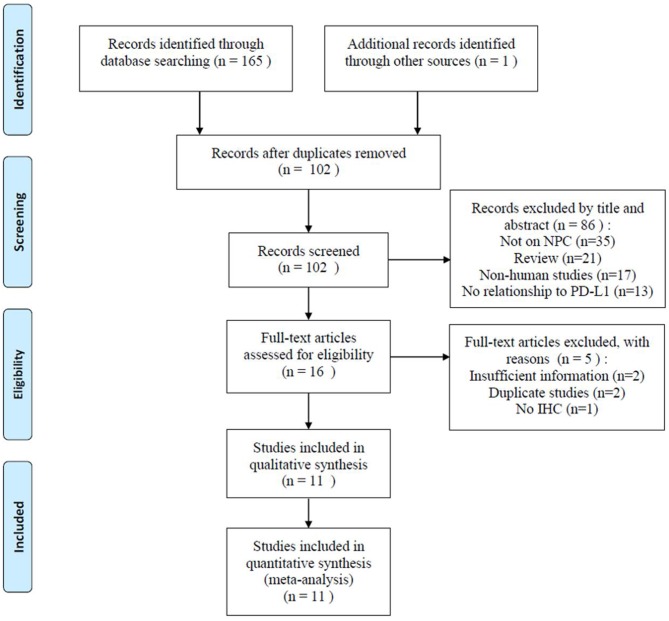
Flowchart of study selection.